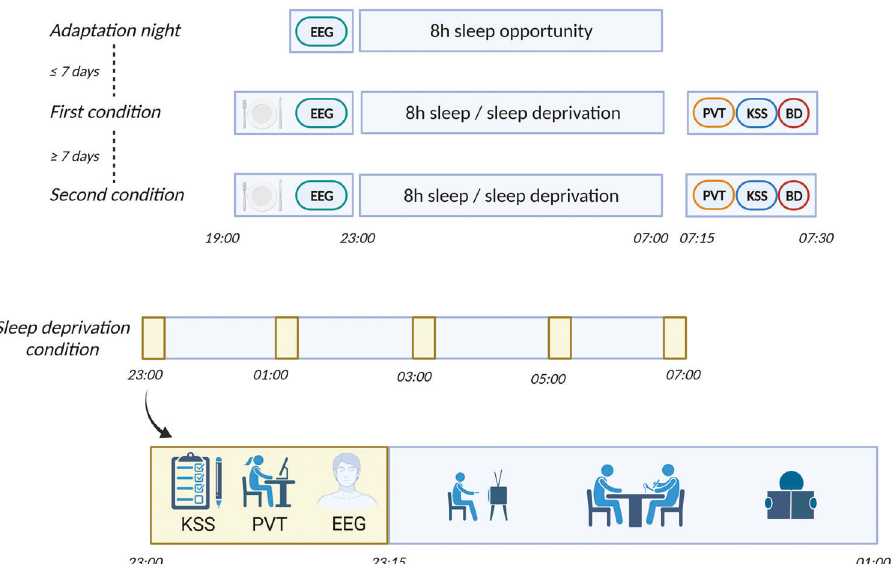
Fig. 1 Experimental scheme. Order of experimental conditions. BD blood drawing, EEG electroencephalography, KSS Karolinska Sleepiness Scale, PVT Psychomotor vigilance